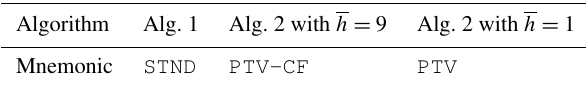
Table 5. The mnemonics used to indicate the algorithm that was used to produce a water vapor estimate. The corresponding test er- rors are also